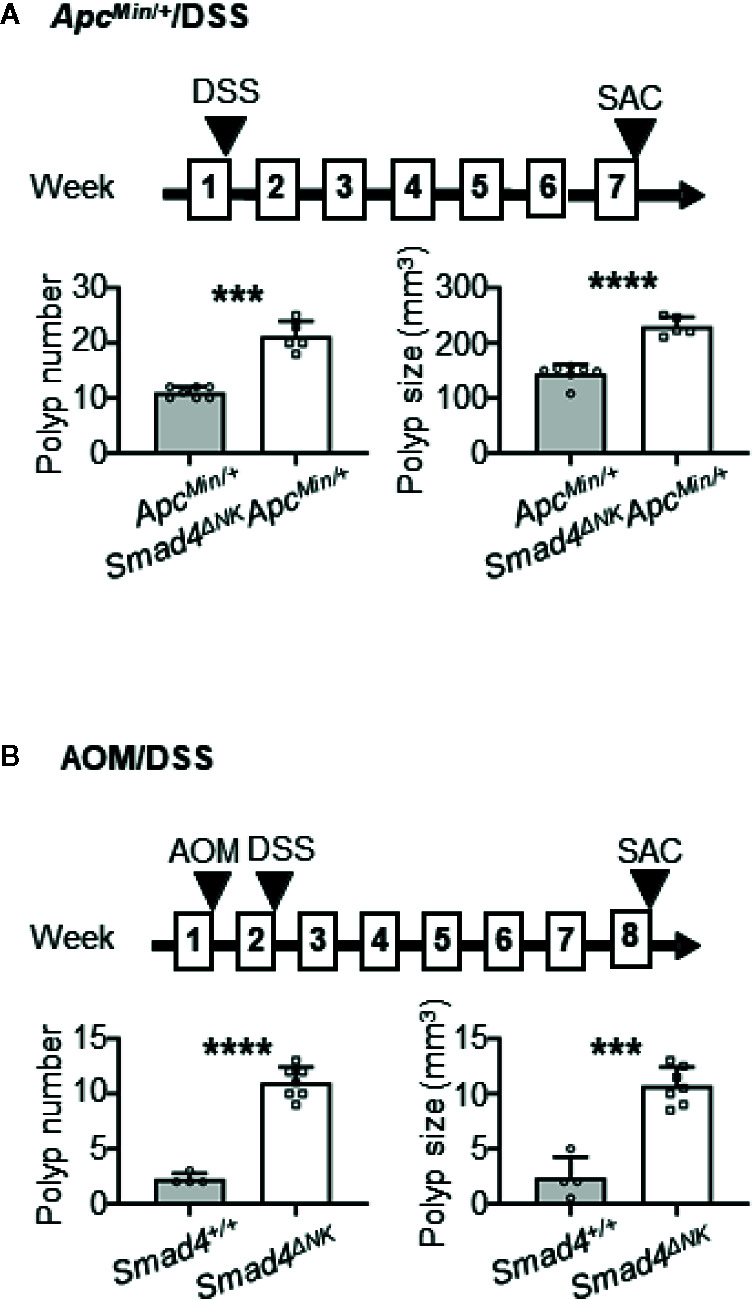
Deletion of Smad4 in NK cells promoted colon adenoma in the ApcMin/+/dextran sulfate sodium (DSS) mouse model, and promoted adenocarcinoma in the azoxymethane (AOM)/DSS model. (A) Evaluation of adenoma numbers and sizes in ApcMin/+ and Smad4ΔNKApcMin/+ mice treated overnight with DSS (n=5–7). (B) Evaluation of adenocarcinoma numbers and sizes in Smad4+/+ and Smad4ΔNK mice treated with AOM and then overnight with DSS (n=4–7). SAC: mouse euthanized. The circles and squares on the bar graphs denote data from individual mice. ***p < 0.001; ****p < 0.0001.